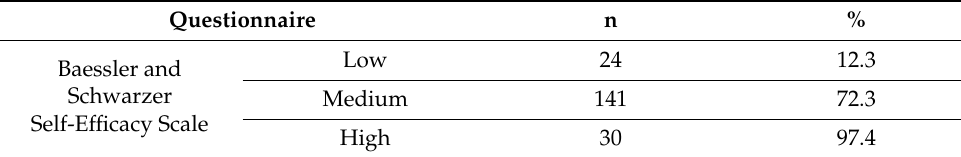
Table 1. Descriptive statistics of self-efficacy.